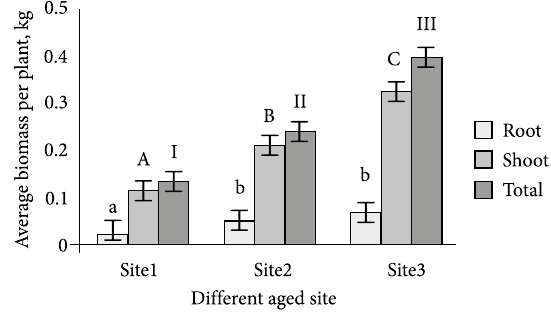
Fig. 3. Average shoot, root and total biomass per plant at different aged fly ash dump sites for n = 7 replicates. Different lowercase, uppercase and roman letters above each type of bar represent significant difference between the means for the parameter at p < 0.05